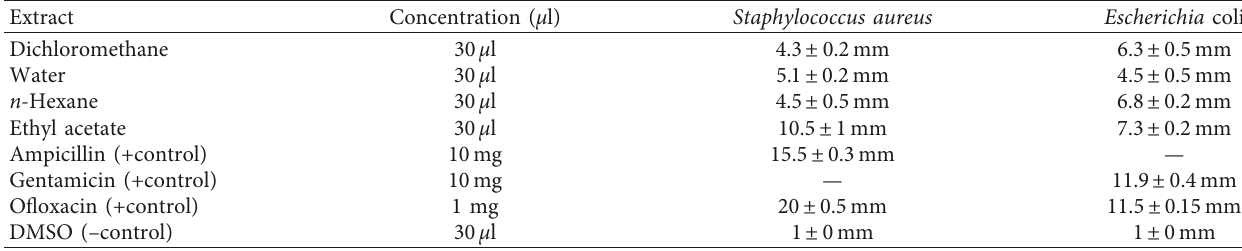
Table 1: Result of antibacterial activity of Veronica biloba.